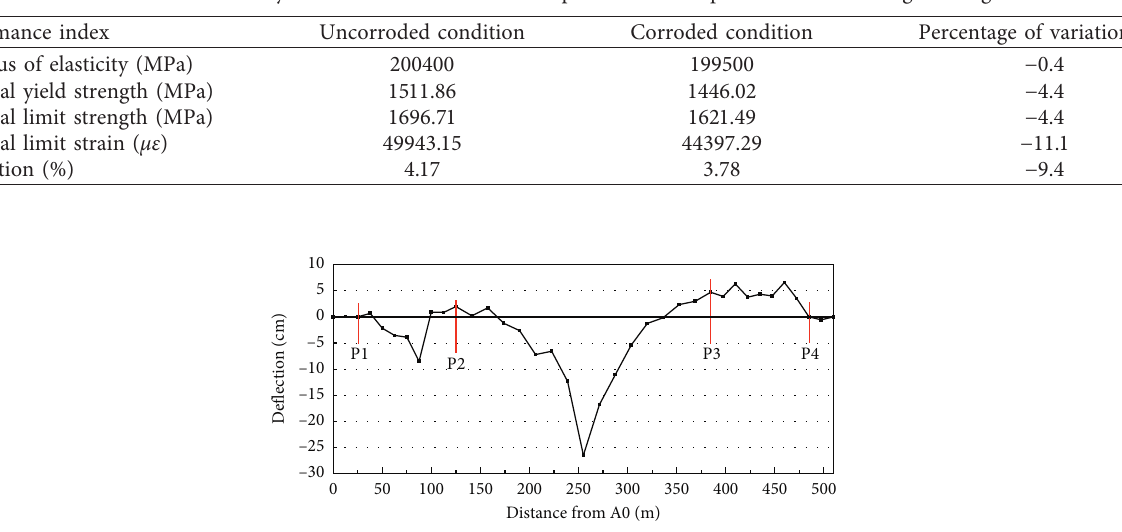
Figure 6: Measured deflection of bridge deck before cable replacement.